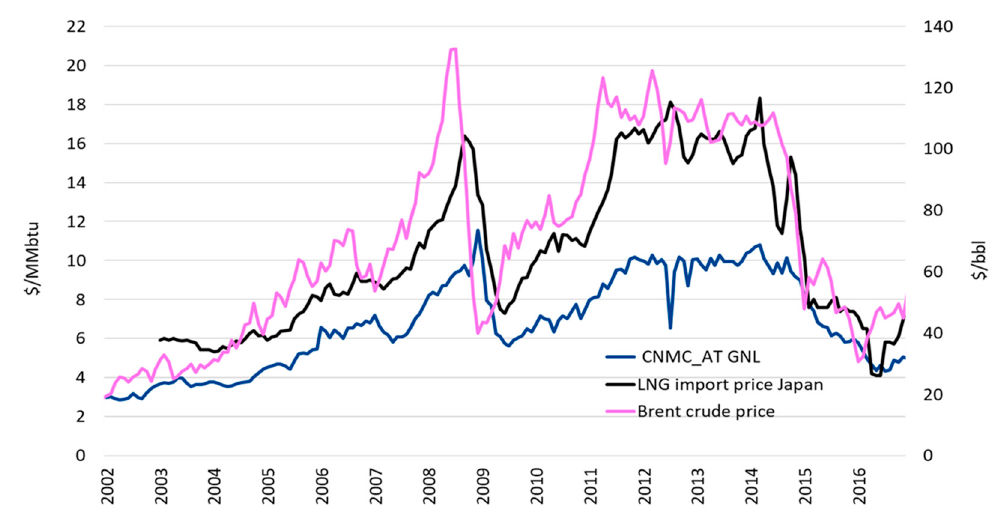
Figure 5. Brent vs. Spanish and Japanese import prices.